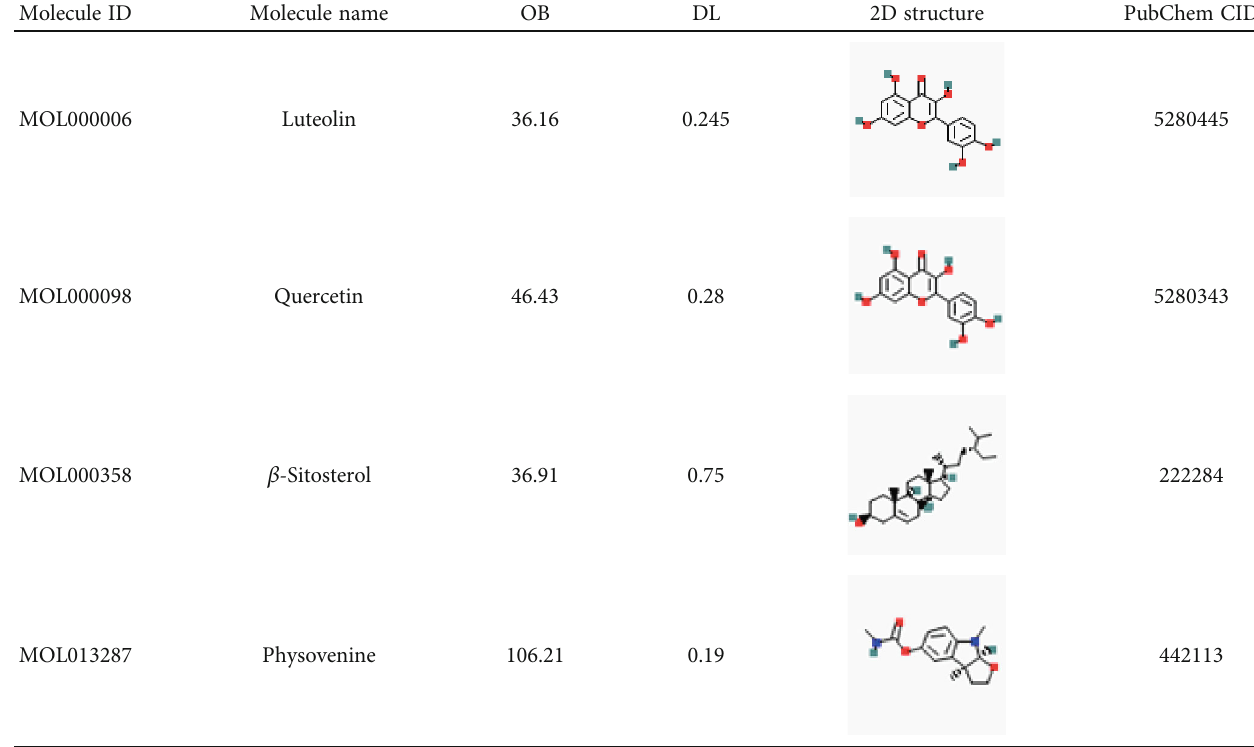
Table 2: Core pharmaceutical components of